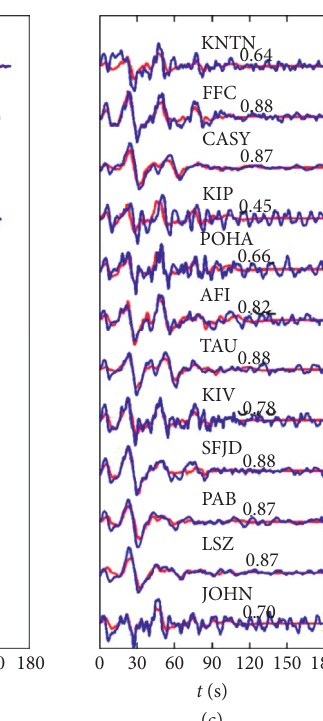
Figure 7: Comparison between teleseismic P waveforms (blue curves) and synthetic records (red curves). Number indicates the correlation coefficient.